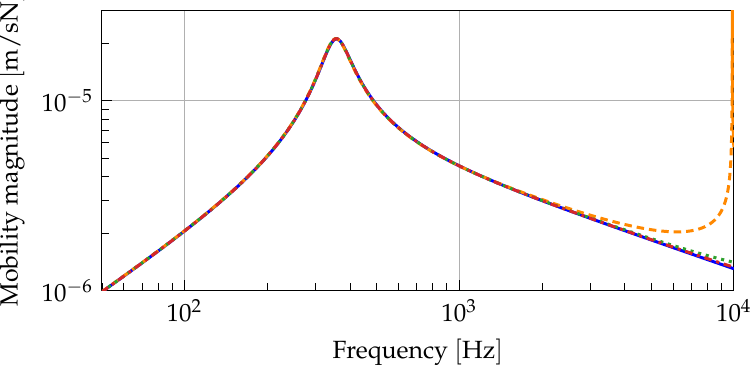
Figure 8. Point mobility of an undamped infinite beam on a continuous single-layer support for different time steps.